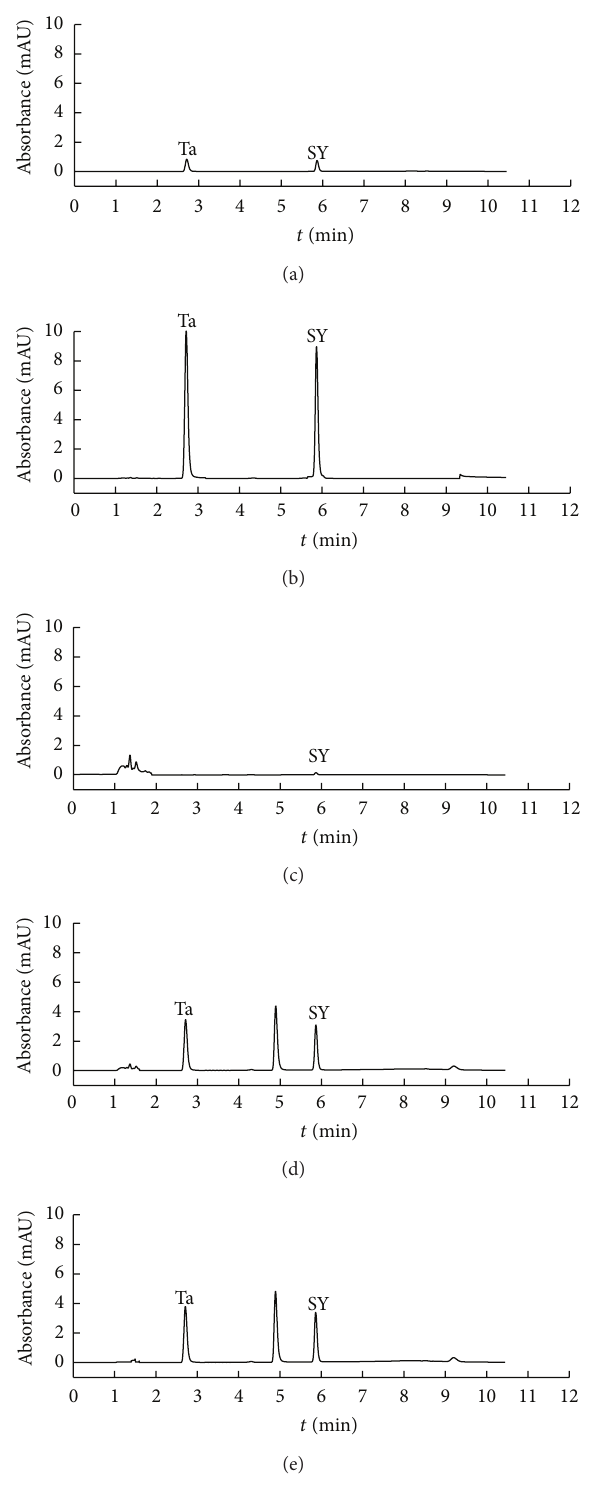
Figure 7: The chromatograms of standard solution and sample solution before and after extraction. (a) Standard solution of 0.25 𝜇 g/mL Ta and 0.25 𝜇 g/mL SY; (b) standard solution of 0.25 𝜇 g/mL Ta and 0.25 𝜇 g/mL SY after IL-salt ATPS extraction; (c) candy sample solution without pretreatment; (d) candy sample solution with polyamide adsorption method; (e) and candy sample solution = 0.30 mL, 𝑚 = 3.0 with IL-salt ATPS ( 𝑉 IL K 2 HPO 4